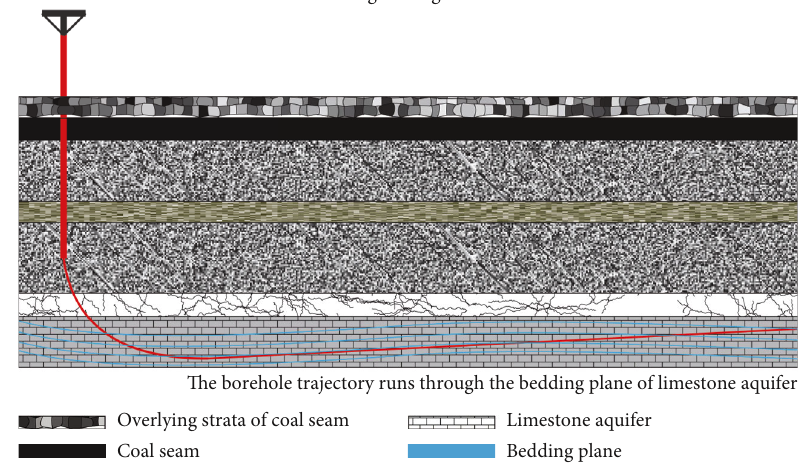
Figure 4: Schematic diagram of directional bedding drilling crossing the bedding plane of thin limestone.